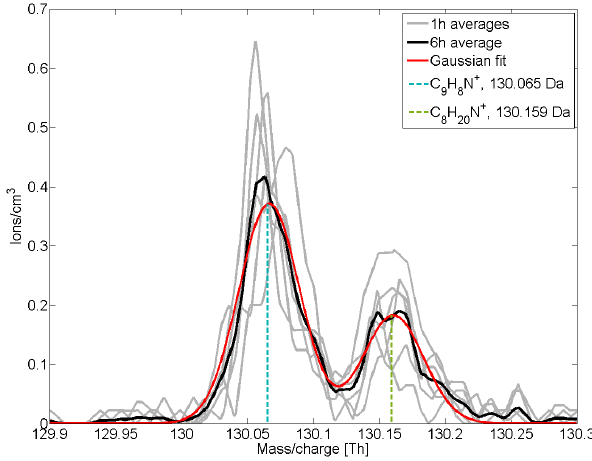
Fig. 12. High resolution spectrum of integer m/Q 130Th in the positive ion spectrum, showing the clear separation between two peaks, most likely quinoline and an alkyl amine.